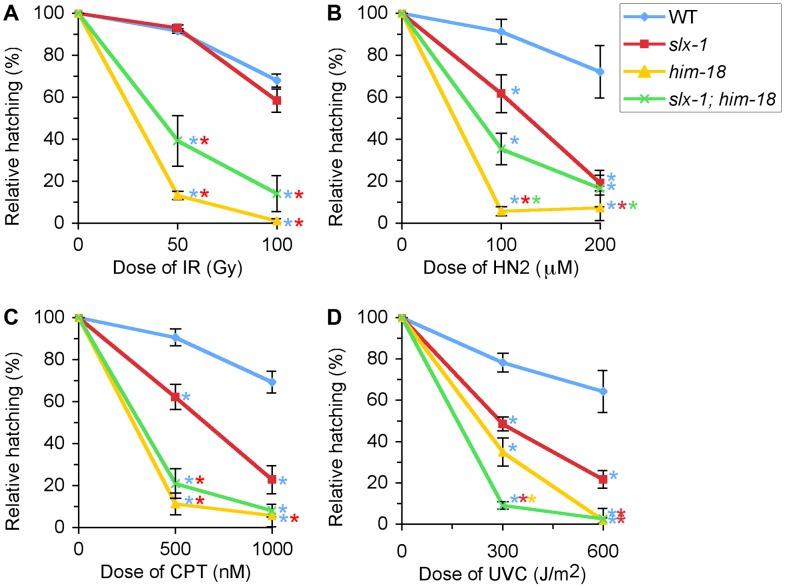

slx-1 mutants exhibit hypersensitivity to nitrogen mustard, camptothecin, and ultraviolet C, but not ionizing radiation.Relative hatching frequencies detected in wild type, slx-1, him-18 and slx-1;him-18 mutants after treatment with the indicated doses of (A) ionizing radiation (IR), (B) nitrogen mustard (HN2), (C) camptothecin (CPT), and (D) ultraviolet C (UVC). Hatching is plotted as a fraction of the hatching observed in untreated animals. Error bars indicate standard error of the mean for ∼20 animals in each of three independent experiments. Colored asterisks indicate statistical significance between different genotypes.